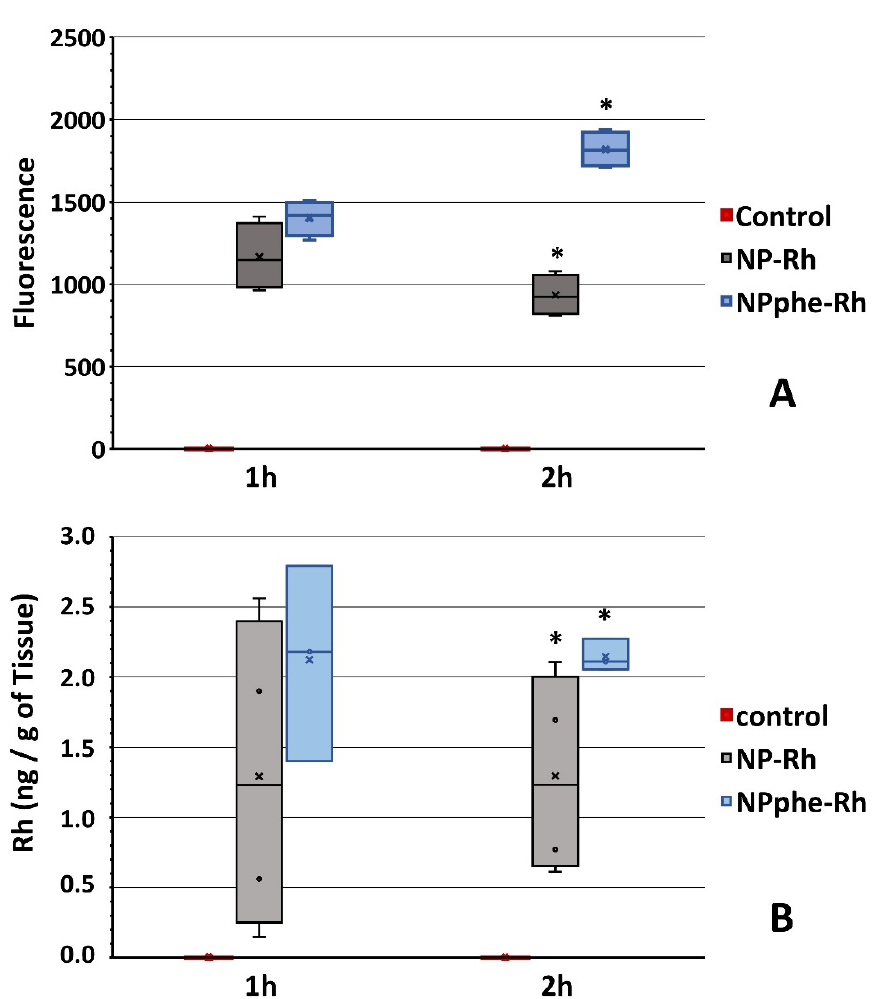
Figure 6. ( A ) Mean fluorescence intensity ( ± SD) of Rh-B in brain samples at times 1 h and 2 h measured by ImageJ software. ( B ) Mean amounts ( ± SD) of Rh-B in brain samples at times 1 h and 2 h determined by fluorescence spectrophotometry. Control corresponds to non-treated animals. * Statistically significant differences ( p -value < 0.05).